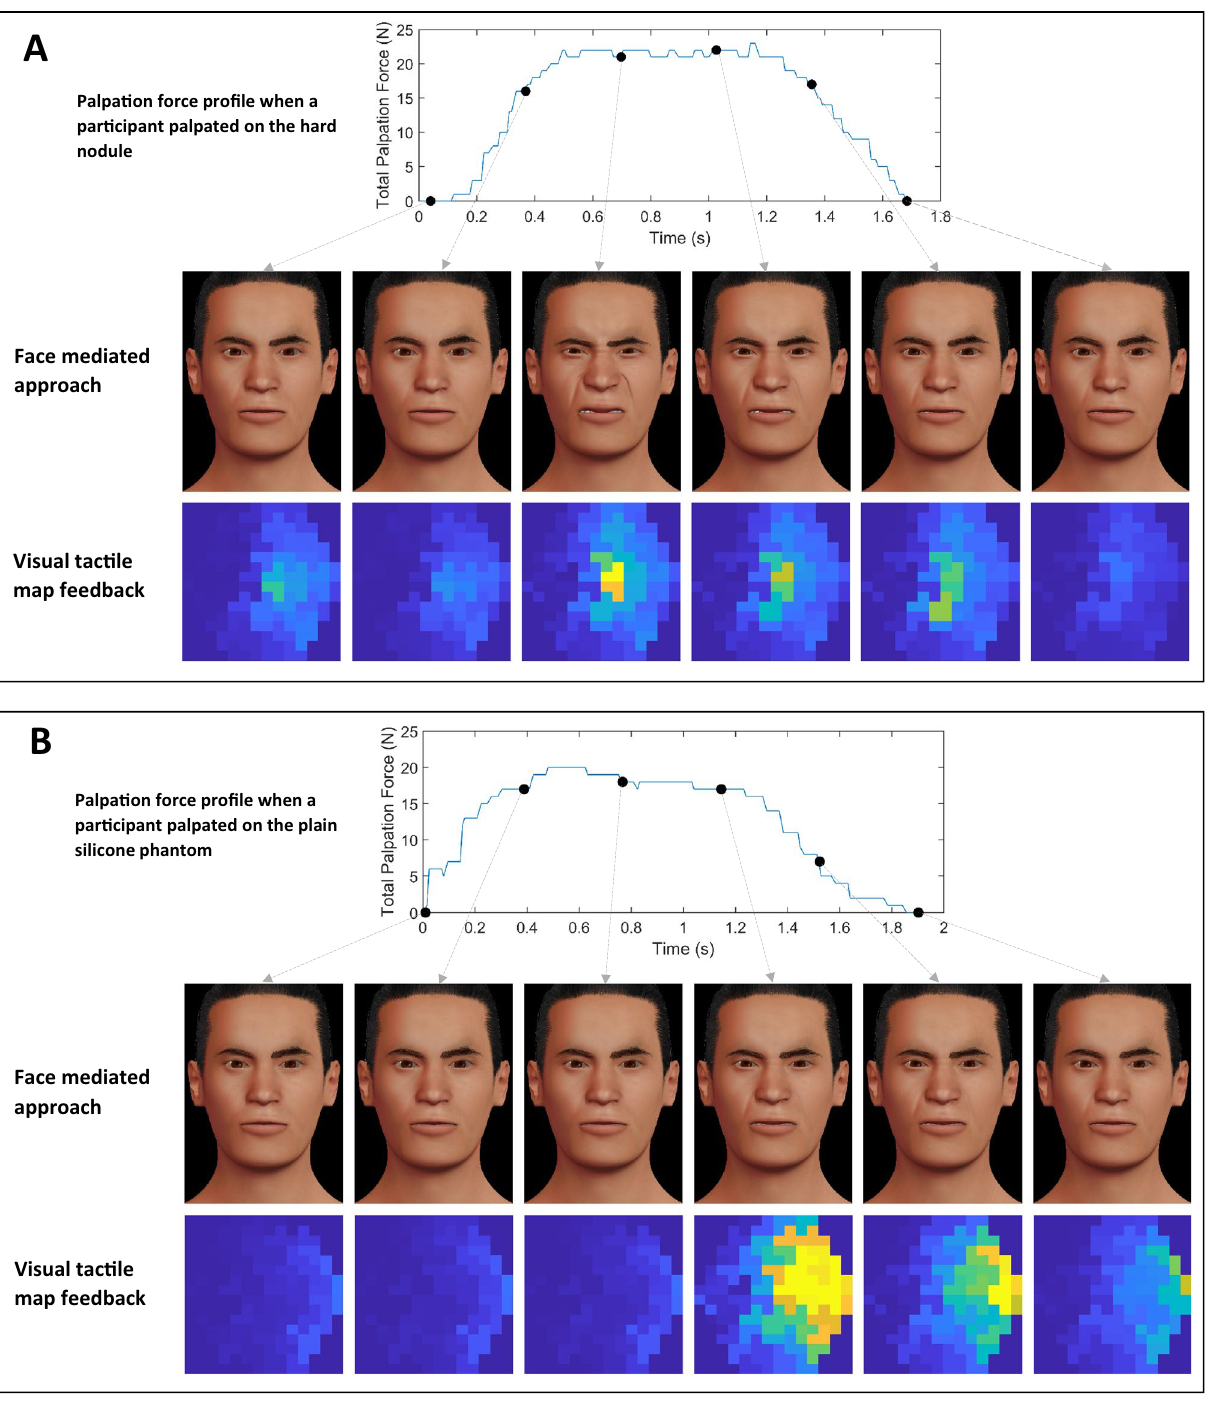
Figure 3. How pain facial expressions of the MorphFace in face mediated approach and corresponding visual tactile map feedback varies for different palpation forces. (A) top plot shows the palpation force profile when a participant palpated on the hard nodule and corresponding pain expressions rendered on the Morphface and respective tactile information displayed as the visual tactile map. (B) depicts the same information as in (A) but when a participant palpated on the plain silicon phantom. MATLAB 2020a (https:// www. mathw orks. com) is used to generate the